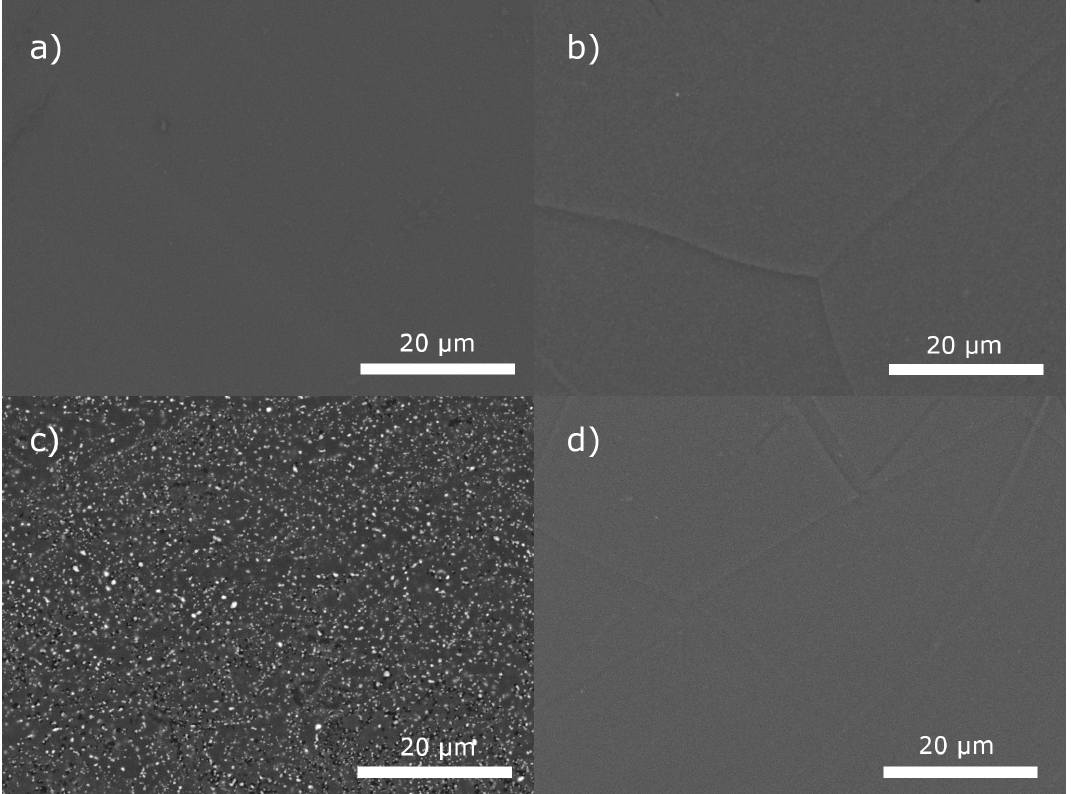
Figure 1. SEM BSE images of the wire cross section of ( a ) Mg-2Ag recrystallized, ( b ) Mg-2Ag sol. annealed, ( c ) Mg-6Ag recrystallized, and ( d ) Mg-6Ag sol.